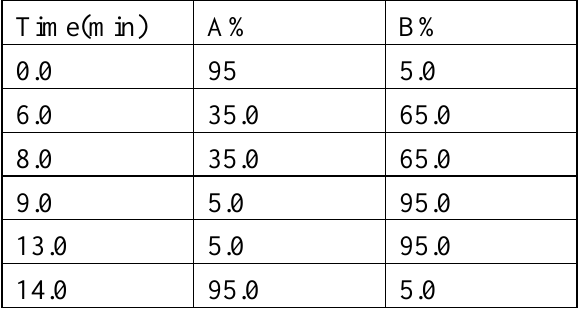
Table 1 . The HPLC gradient program with DMHA